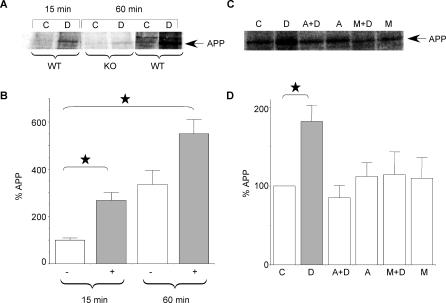
mGluR Activation Increases APP Translation in SNs(A) Immunoprecipitated, 35S-labeled APP (120-kDa band) from WT (15 min) and KO and WT (60 min) SNs analyzed by SDS-PAGE and (B) plotted as a percentage of APP synthesis; n = 3 repetitions. Asterisk indicates significant differences, with p = 0.008 between ±DHPG samples at 15 min and p = 0.016 between control at 15 min and DHPG at 60 min. For the control samples at 15 and 60 min, p = 0.056, and for the samples with or without DHPG at 60 min, p = 0.05. (C) Immunoprecipitated, 35S-labeled APP (120-kDa band) from WT SNs treated with DHPG, anisomycin, and MPEP, analyzed by SDS-PAGE, and (D) plotted as a percentage of APP synthesis; n = 3 repetitions (DHPG), n = 4 (anisomycin + DHPG and anisomycin), and n = 5 (MPEP + DHPG and MPEP).